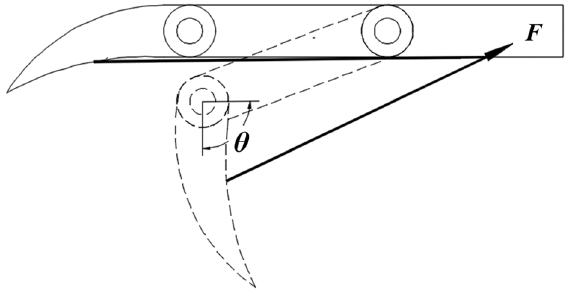
Figure 4. Diagram of a toe grasping motion.